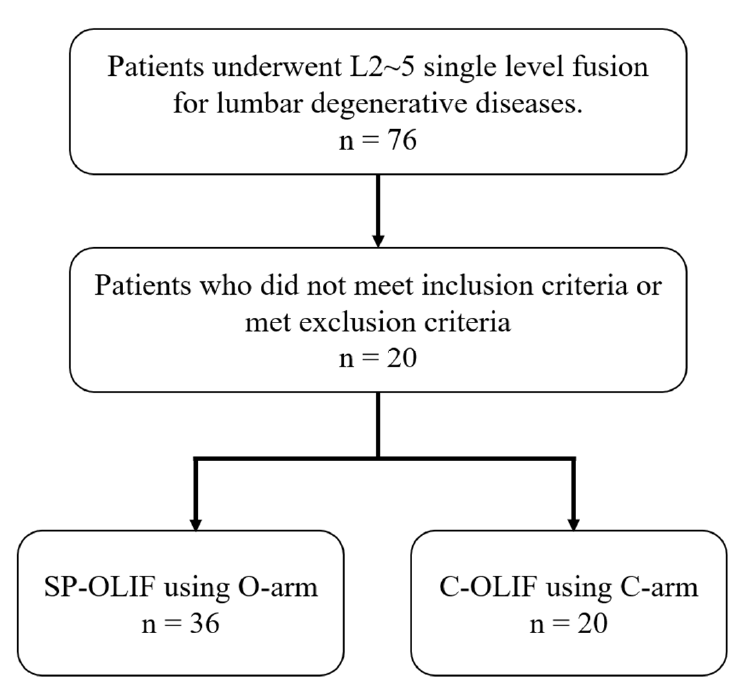
Figure 1. Patient enrollment.